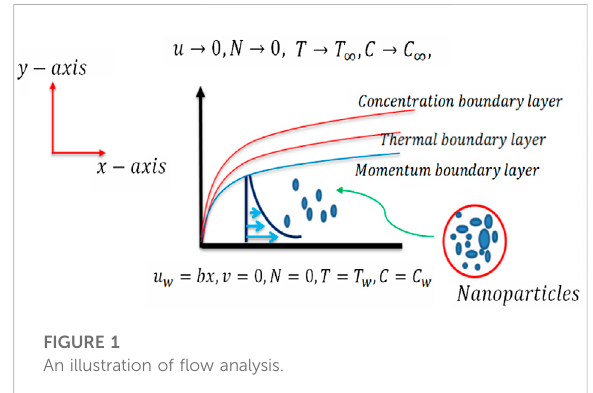
FIGURE 1 An illustration of fl ow